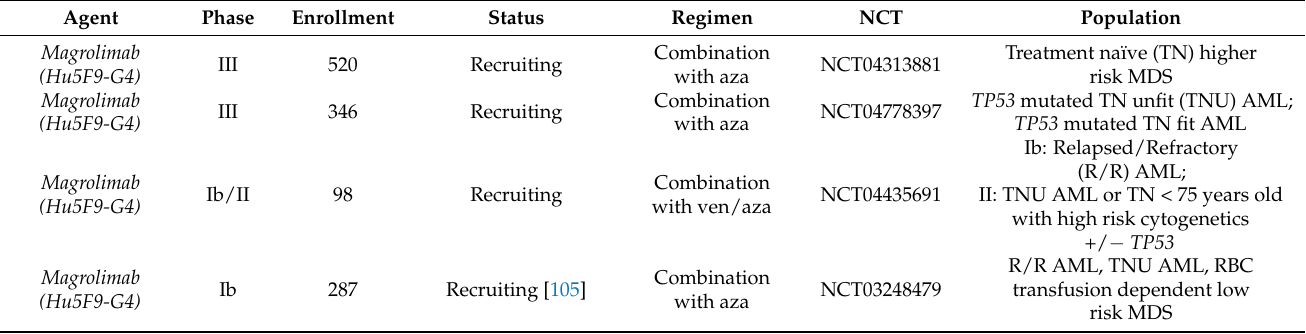
Table 2. Anti-CD47 Agents in Clinical Development. Abbreviations: AML, acute myeloid leukemia; aza, azacitidine; CMML, chronic myelomonocytic leukemia; F, fit for intensive chemotherapy; MDS, myelodysplastic syndrome; R/R relapsed or refractory; TN, treatment naïve; U, unfit for intensive chemotherapy; Ven, venetoclax. Note: * SIRPa targeting agent, all others target CD47. The following agents are in clinical development but AML patients not included in study: TG-1801, A0-176, TG1801 (anti-CD19 CD47 bispecific), IMC-002, STI-6643, SL-172154, ZL-1201, IMM01, & SRF231 (no longer in active development); PF-07257876 and IBI322 (anti-CD47 and PD-L1); IMM-0306 CD47xCD20 bispecific. SRF231 showed 90% receptor occupancy no complete or partial responses in solid tumor and lymphoma cohorts, development has been suspended. The following agents target SIRPa